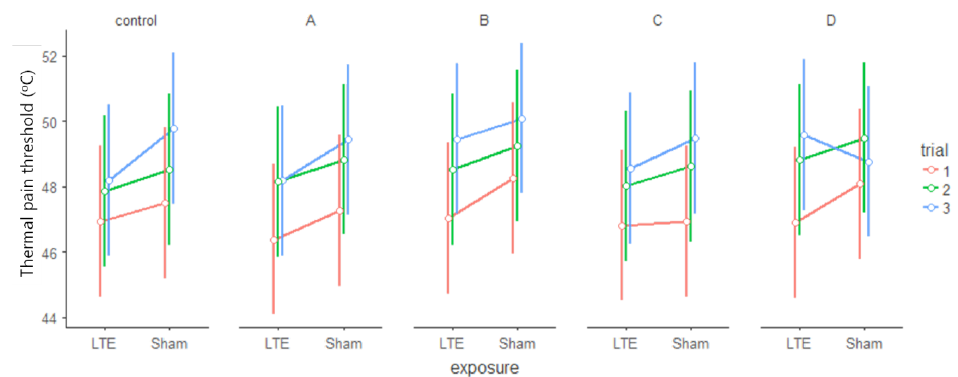
Figure 3. Thermal pain thresholds elevated in trials of the individual blocks. Mean TPTs (°C) of blocks (control, A–D) of trials (1, 2, 3rd) in the Real (LTE) and in the Sham (Sham) condition. Error bars: confidence intervals (95%).